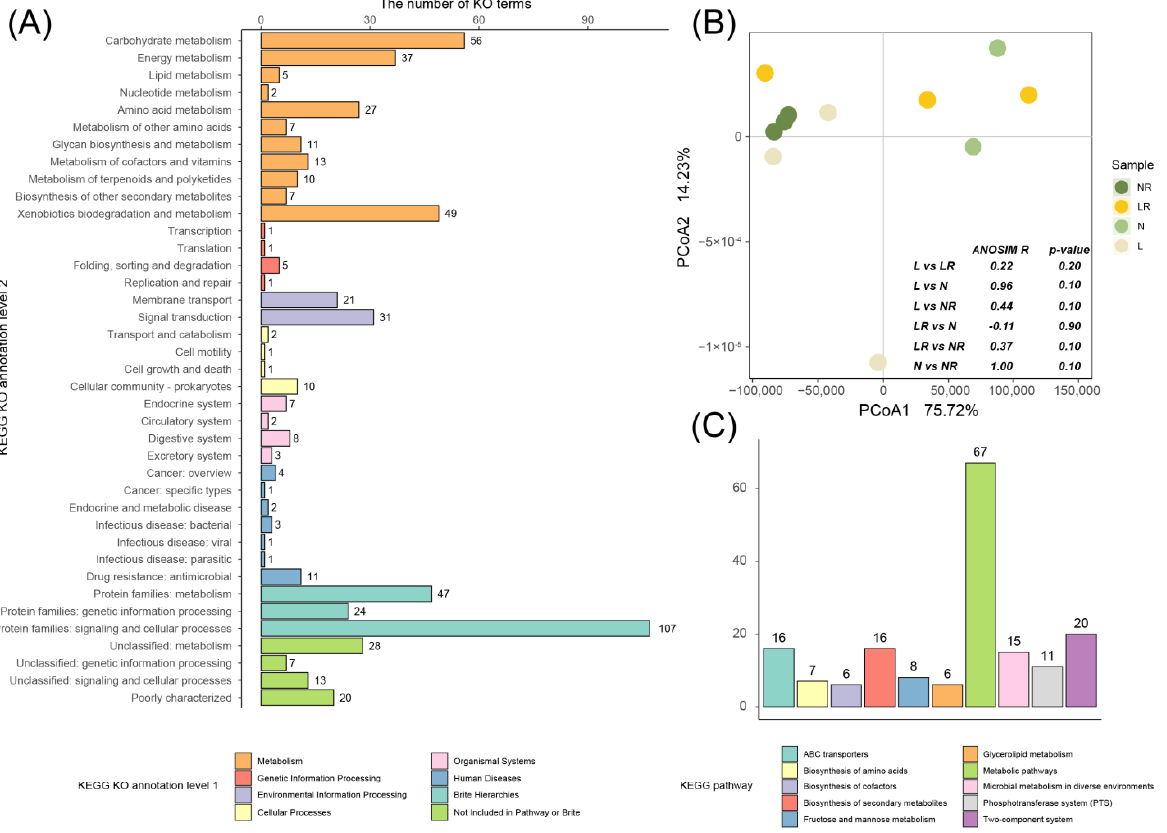
Figure 5. Redundancy analysis between bacterial ( A ) and fungal phyla ( B ) and the physical and chemical properties of soils supporting normal or limited growth of highbush blueberry plants. NR-rhizosphere soil of normally growing plants; LR-rhizosphere soil of plants with limited growth; N-bulk soil of normally growing plants; L-bulk soil of plants with limited growth. The colored dots are replicate samples of different sample types, and the geometric shapes are bacterial or fungal phyla.